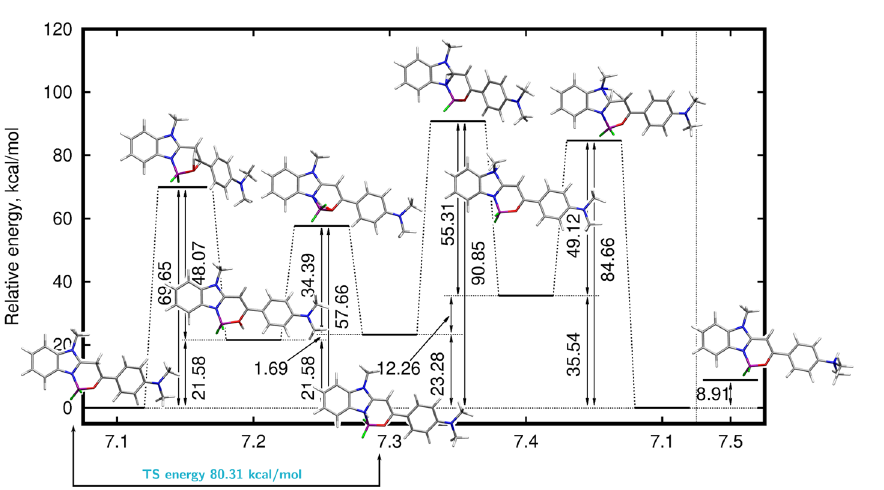
Figure 8. Mechanism of possible proton transfer processes in [ 7 +H] + ion calculated within the ω B97X-D/6- 311++G(d,p) approach (in blue transition state relative energy for proton transfer from N7 to C10 is given; corresponding figures for [ 8 +H] + and [ 9 +H] + provided in Fig. S7 and